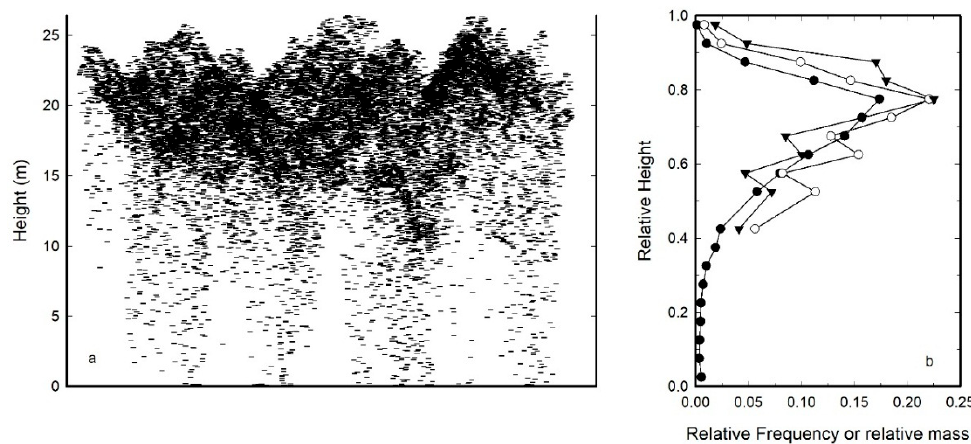
Figure 2. Section view of LiDAR elevation values from a 25 m × 25 m plot in a 36-year-old loblolly pine stand in southeastern Louisiana ( a ) and the distribution of elevation values (closed circles) overlain on the measured distribution of crown mass (branch plus foliage) (open circles) and foliage mass (closed triangles) for the same plot ( b ). Data in ( a ) collected with an Optech ALTM-1225 laser mapping system operating at 25 kHz and a scanning angle of ± 9 ◦ . Analysis in ( b ) based on Cao and Dean